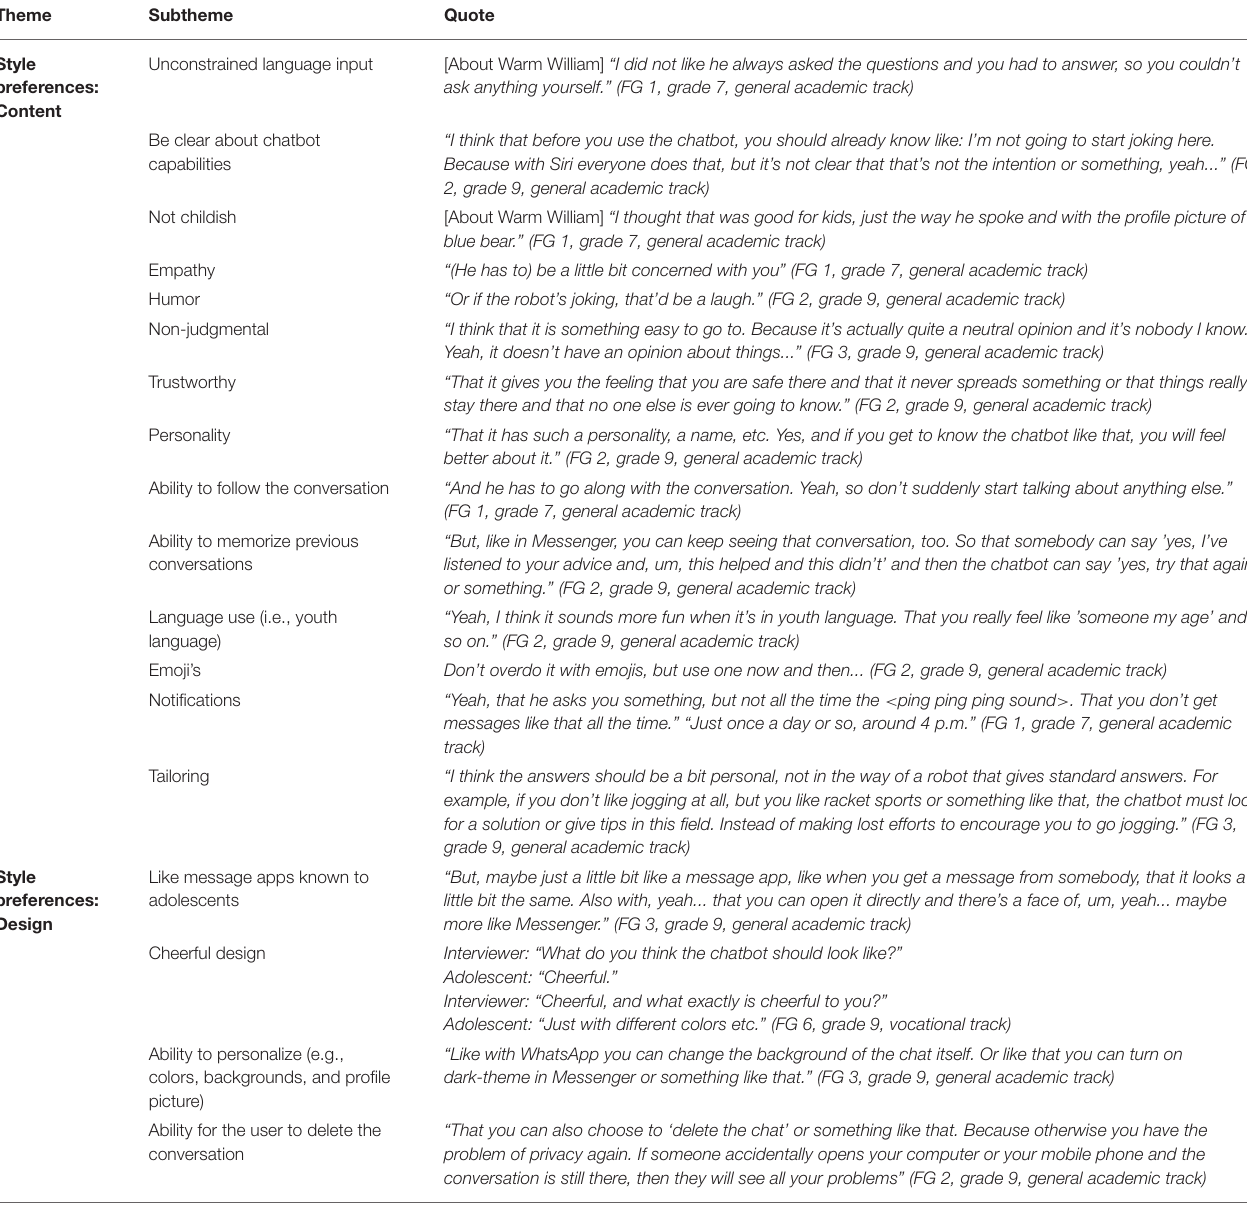
TABLE 1 | Results from the focus groups regarding style preferences.